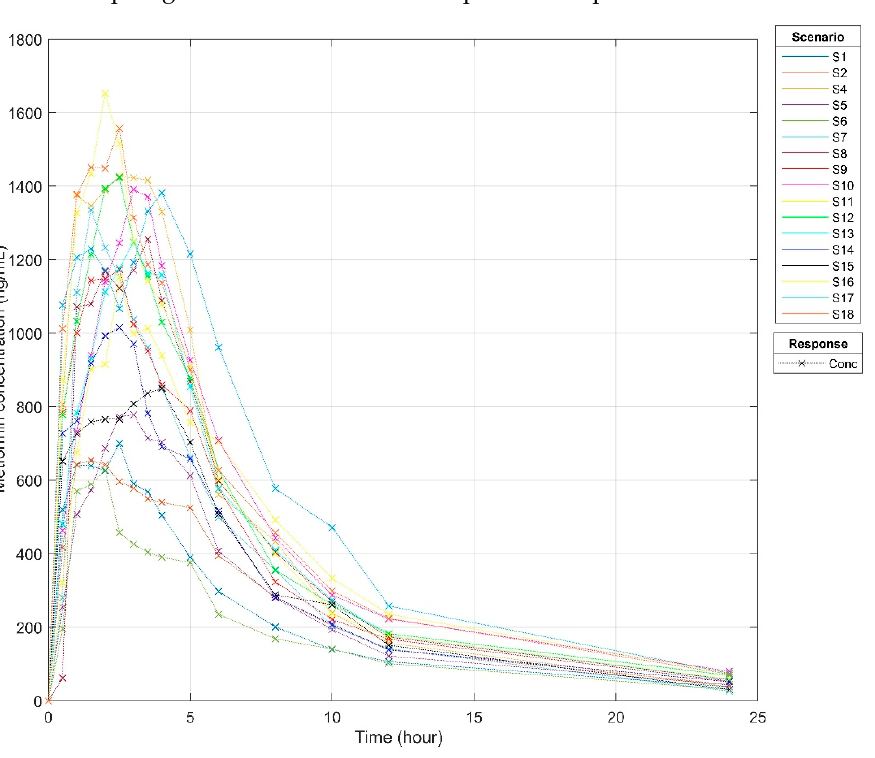
Figure 3. Metformin pharmacokinetic plasma concentration time curve in 17 healthy subjects. S1–S18 are 17 healthy volunteers, S3 was not present on dosing day.